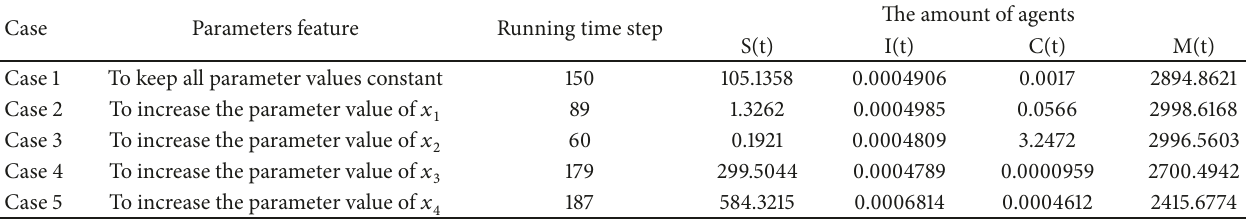
Table 2: The evolutionary characteristics of agents after finishing simulation